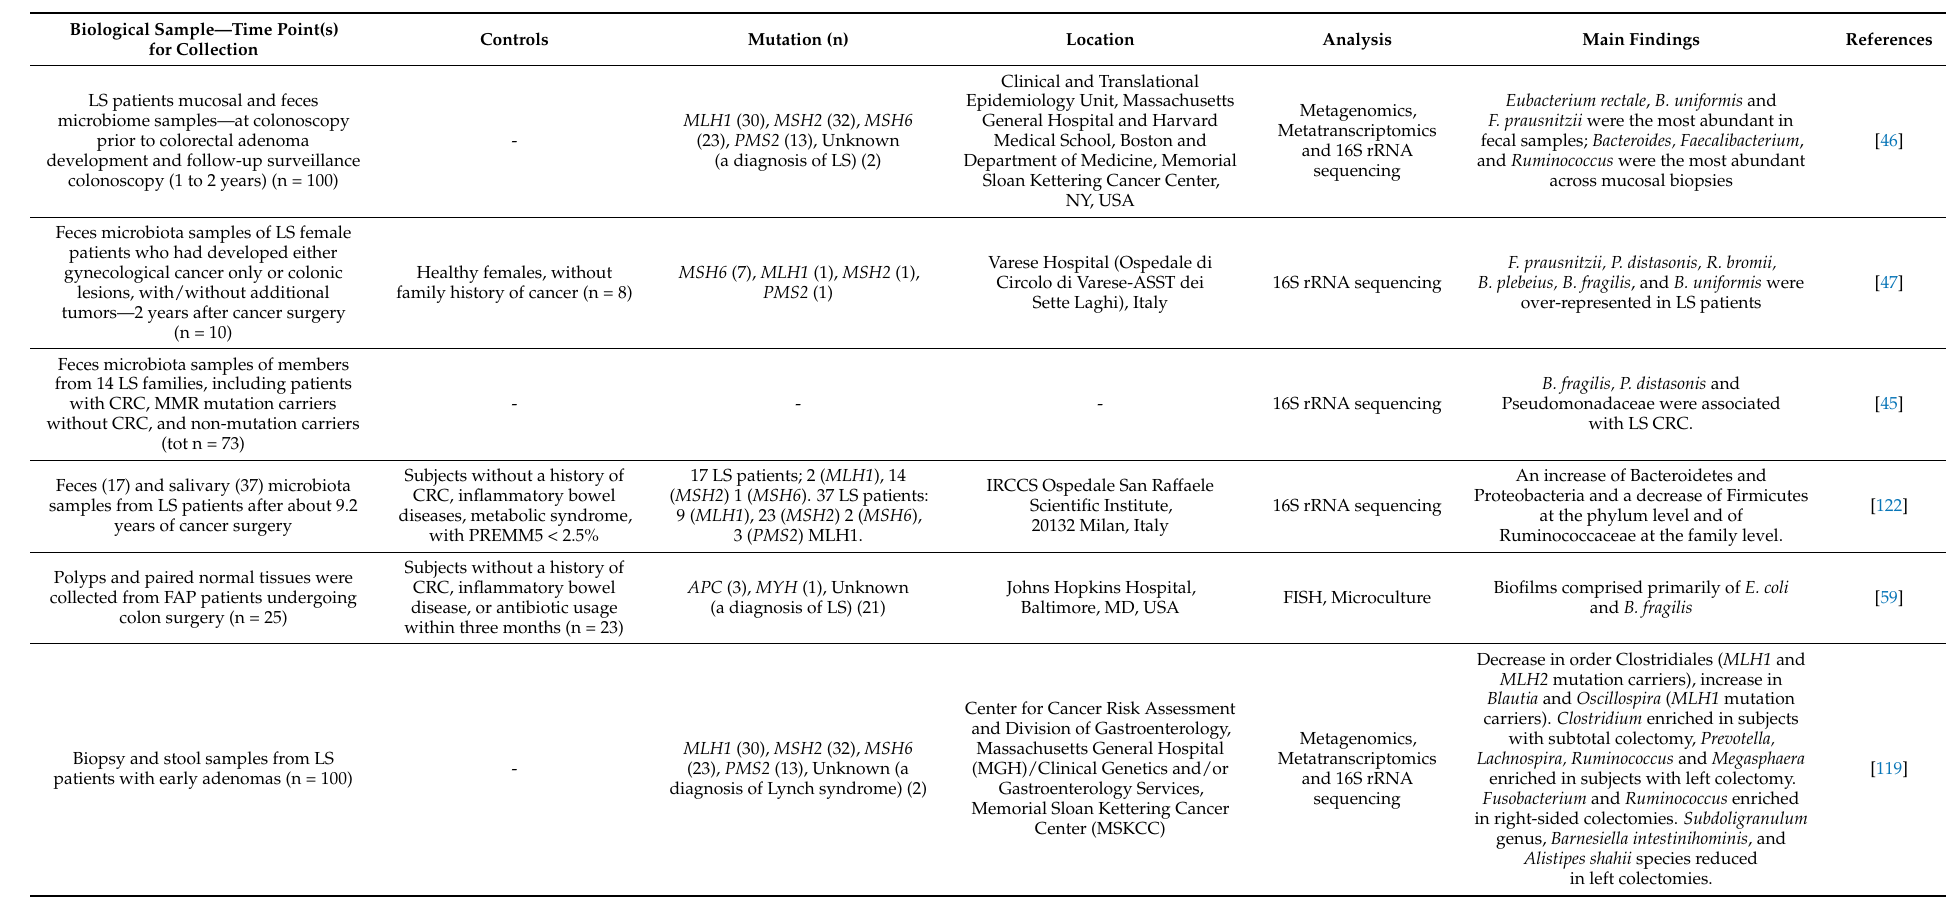
Table 3. Overview of human studies investigating the role of microbiota in the context of hereditary CRC